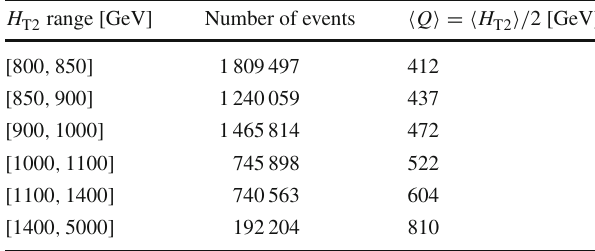
Table1 Summaryofthe H T2 binsusedintheanalysis.Thetableshows thenumberofeventsfallingintoeachenergybintogetherwiththevalue of the scale Q at which the coupling constant α s is